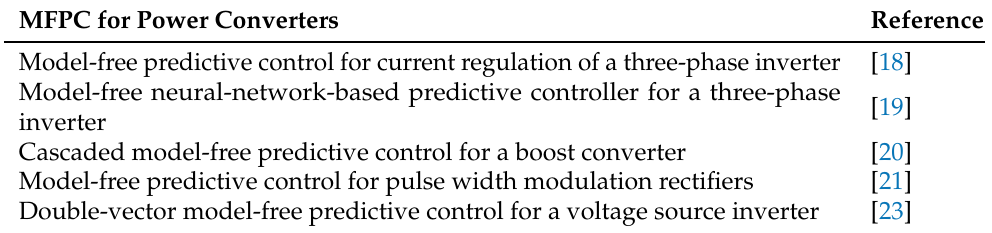
Fig. 10. Experimental bench of SMPMSM drive system.